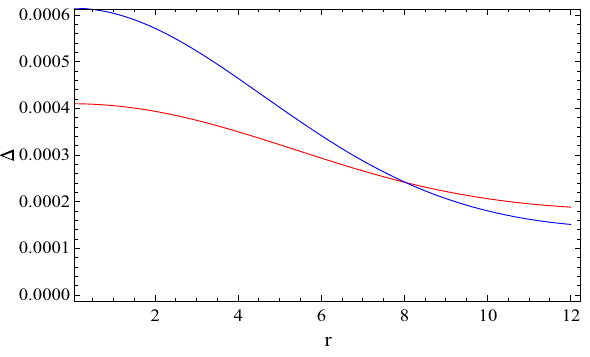
Fig. 19 Variation of the anisotropic parameter of PSR J0348+0432 with matter distribution following Chaplygin EoS [ α = 0 (blue) and α (cid:5)= 0 (red)]